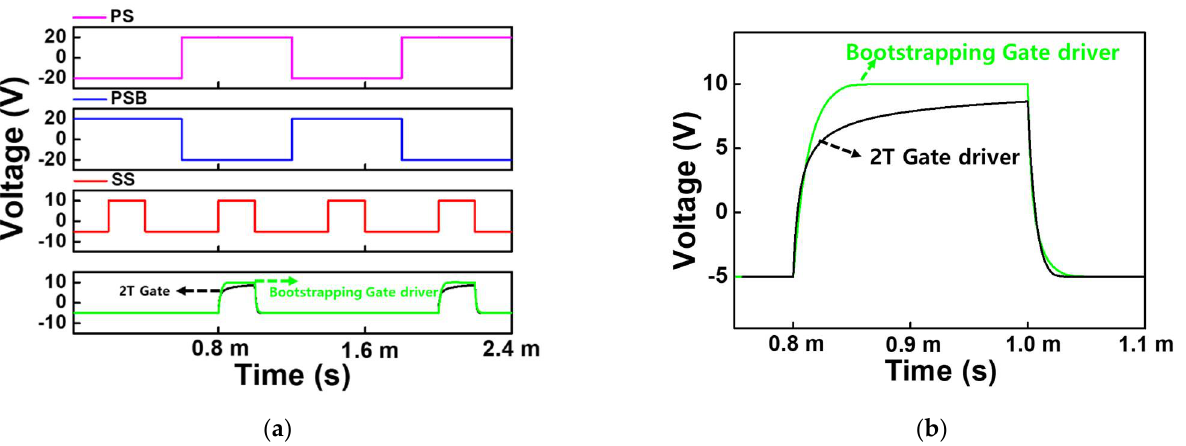
Figure 3. ( a ) Simulated waveforms for both the proposed circuit and 2TFT circuit; ( b ) comparison between two outputs. Table 1. Comparison of driving characteristics of the proposed circuit and 2TFT circuit.